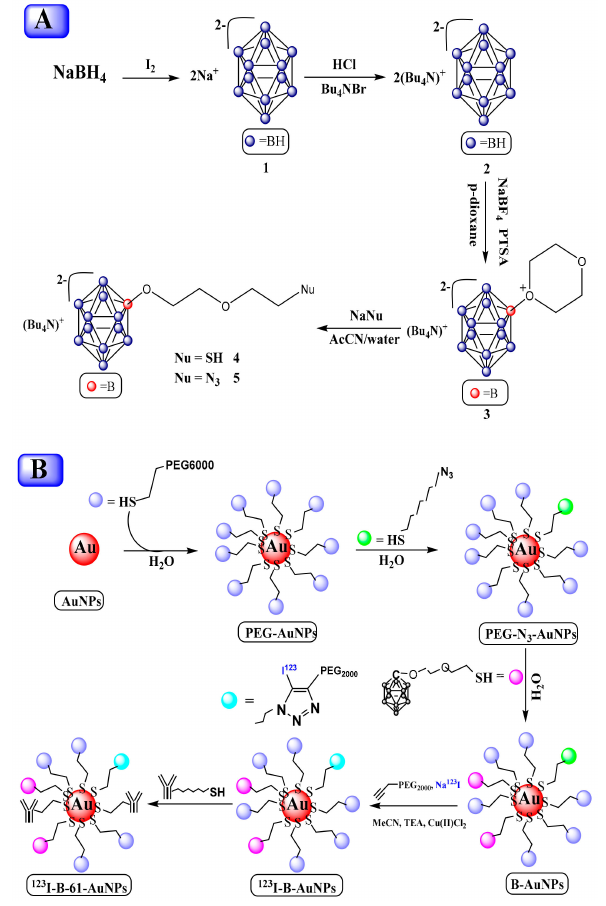
Figure 7. ( A ) The synthetic scheme of boron cage-SH (4), ( B ) The synthetic scheme of B-AuNP s , 123 I-B-AuNP 123 s and